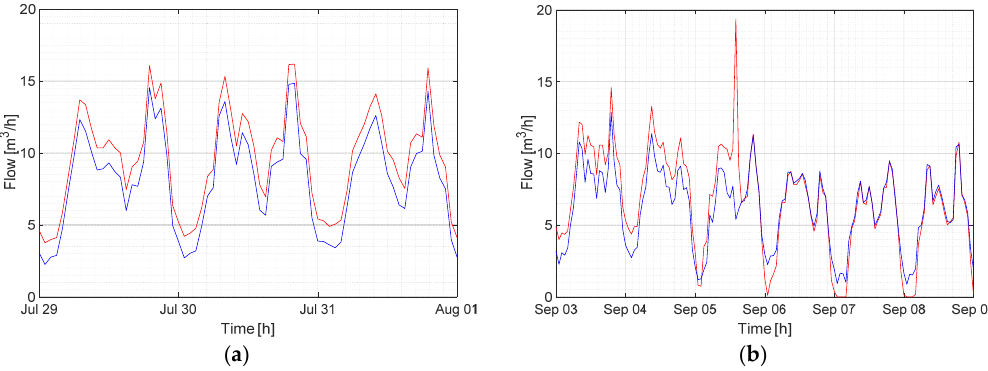
Figure 5. ( a ) Detail of the water balance in July 2016; ( b ) Detail of the water balance before and after the repairing of a break in the distribution network where the red profile indicates the discharge entering the DMA while the blue profile indicates the total user water